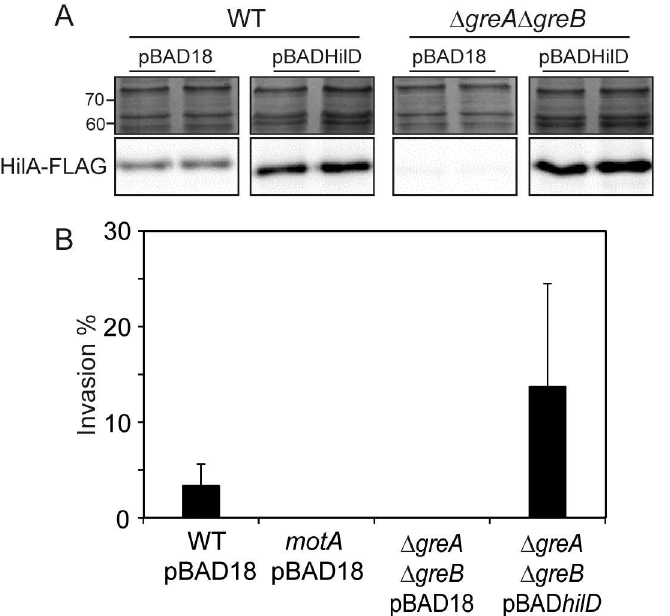
Fig 5. Overexpression of HilD restoresHilA expression and epithelial cell invasiveness in Δ greA Δ greB strains. (A) In lower panels,immunodetection of the HilA-FLAG protein in wholecell extracts from cultures of WT and Δ greA Δ greB derivative strains carryingeither pBAD18or pBADHilDgrown in LB at 37˚C up to an OD 600nm of 2.0, arabinose(0.02%) was added in all cultures. The upper panelsare sections of Coomassie stainedgels as loadingcontrols. (B) Invasionassays using WT, Δ motA and Δ greA Δ greB strains carryingthe indicatedplasmids. Bacterial cultures were grown as in Fig 1. A bar shows the arithmetic mean of experimental results and the error bar indicatesthe standard